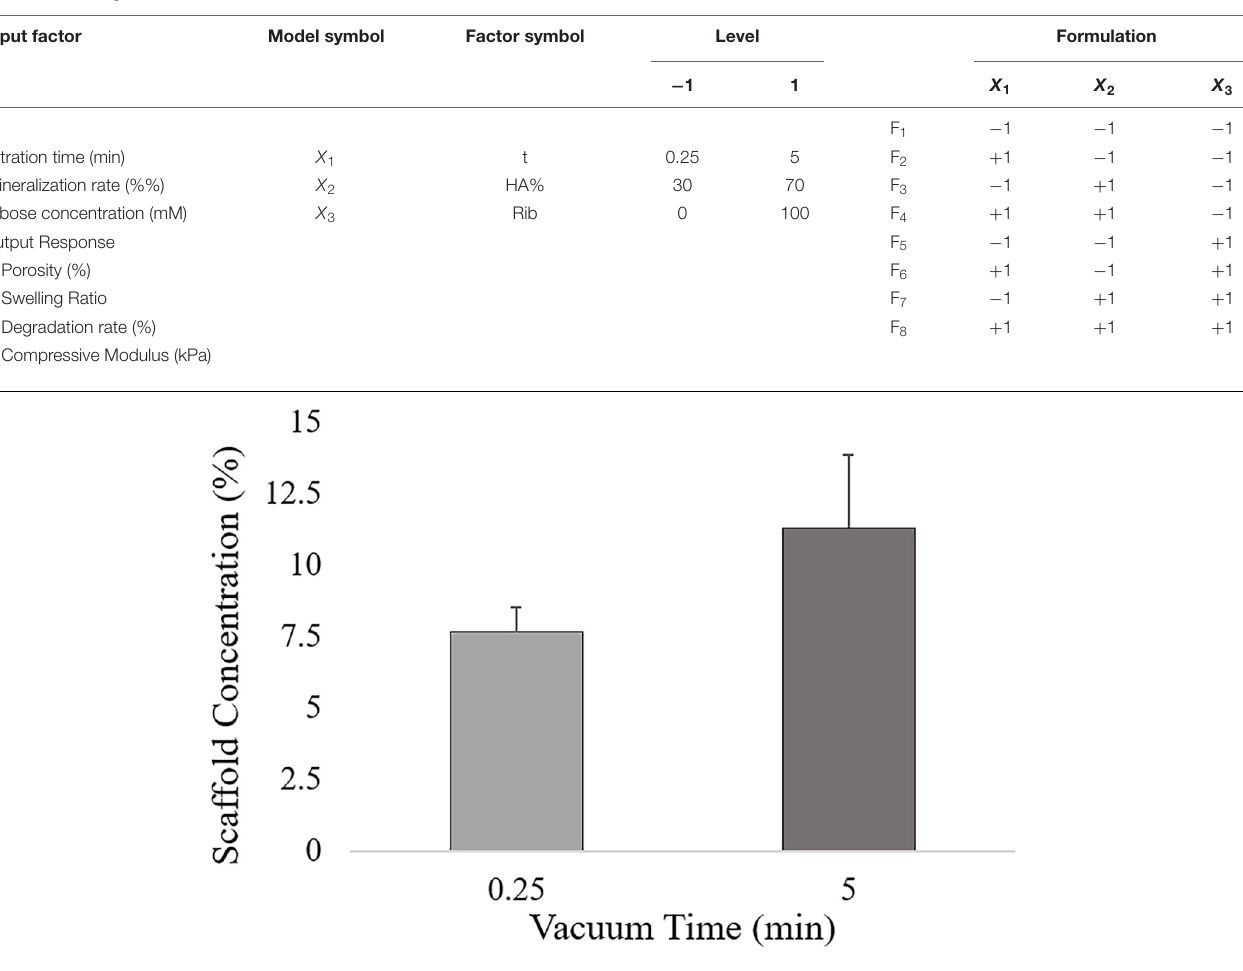
TABLE 1 | List of experimental input factors (left), with the selected levels (two per each factor, coded as − 1 and 1) and the output responses, and (right) the 2 3 design matrix with the eight scaffold formulations.